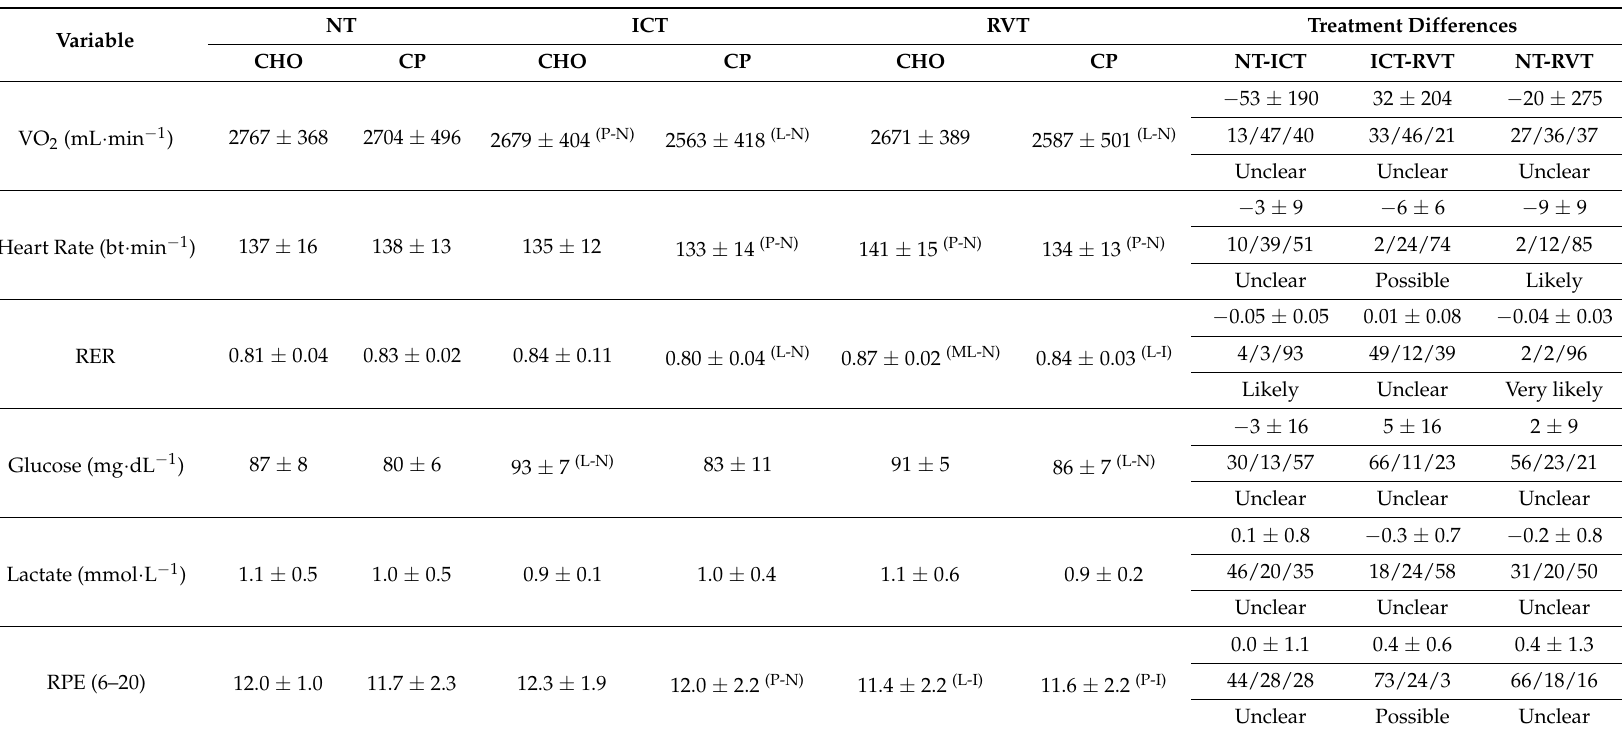
Table 3. Physiological Responses (Mean ± SD) during Constant-Load Cycling (50% W max